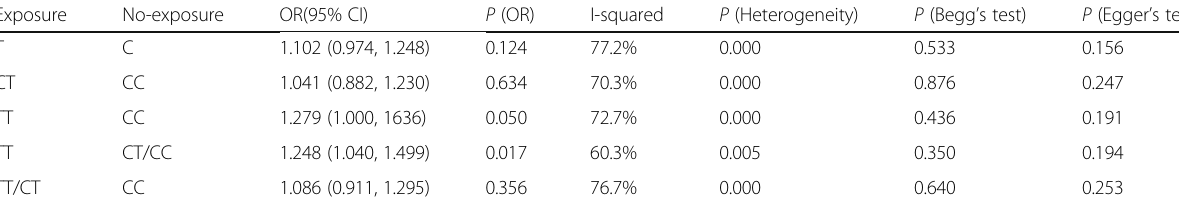
Table 3 Combined results of genotype frequencies in HCC and non-HCC groups in different genetic models Exposure